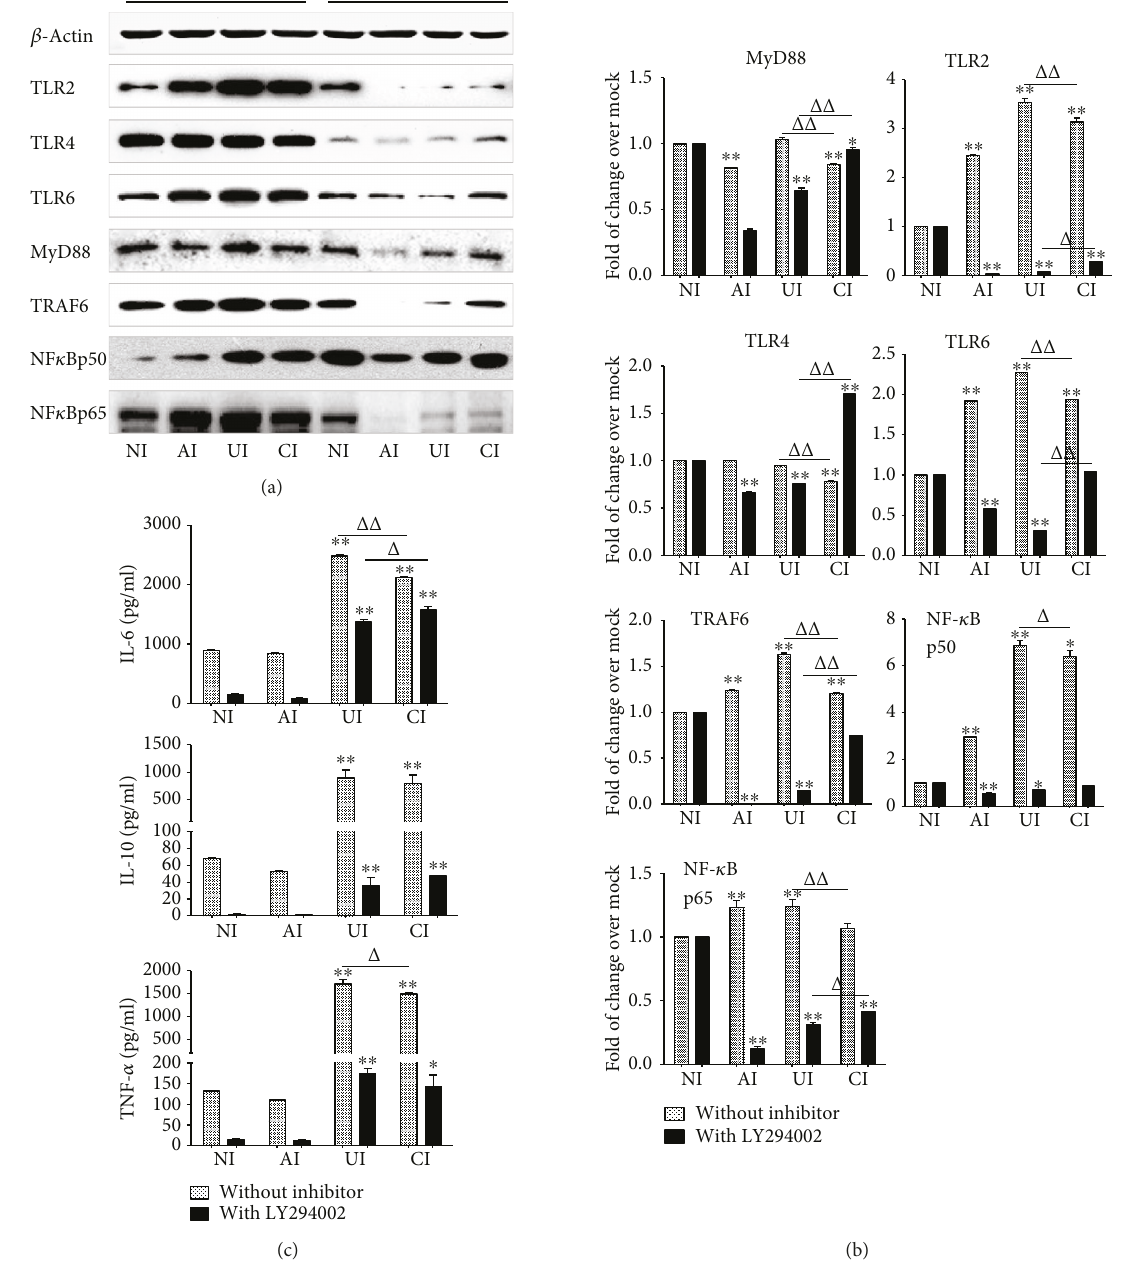
Figure 4: Involvement of PI3K signaling in the reduction of the expression of TLR ligands and elements of TLR signaling pathway in U937 cells to Mtb H37Rv infection in the A549 cell coculture model. In the presence or absence of PI3K inhibitor LY294002, the coculture model of A549/U937 cells was infected with H37Rv mycobacteria from the upper chamber (A549 cells, AI), lower chamber (U937 cells, UI), or both chambers (A549 and U937 cells, CI) at a MOI of 3 for 18 h before the culture medium and U937 cells were harvested for analysis. (a) Representative blots of immunoblotting assay for the indicated components of TLR signaling cascade showed a reversed TLR signaling activity in U937 cells of the coinfection model in the presence of LY294002, in comparison with the absence of an inhibitor. (b) The fold of changes of proteins of interest in (a) semiquantitatively determined by densitometric assay using ImageJ software Fiji from three independent experiments. The ability of A549 cell-mediated reduction of TLR signaling activity in U937 cells was reversed by the addition of LY294002. (c) Concentrations of TNF- α , IL-10, and IL-6 in culture media determined by ELISA; the A549 cell-mediated reduction of cytokines in H37Rv-infected U937 cells was reversed in the presence of PI3K inhibitor. Error bars represent the standard deviation (SD) from three independent experiments. Compared to noninfection (NI) control, ∗ p < 0 05 and ∗∗ p < 0 01 ; compared to the absence of LY294002, Δ p < 0 05 and ΔΔ p < 0 01 . NI: noninfected control; AI: infection was performed on A549 cell alone; UI: infection was performed on U937 alone; CI: infection was performed on both A549 cells and U937